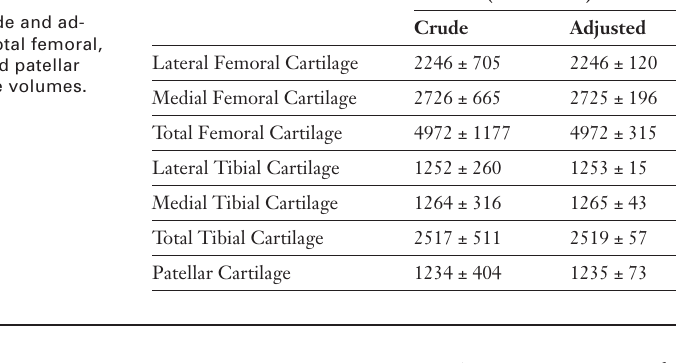
Number and mean volume measure- ments of MR-graded articular cartilages in the tibiofemoral and patellofemoral joints.